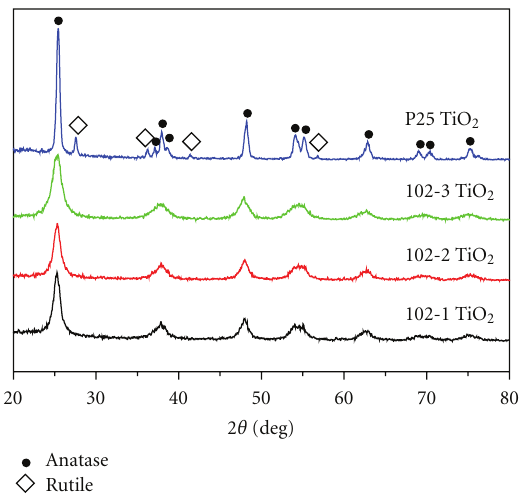
Figure 1: PXRD patterns of the TiO 2 nanoparticles.